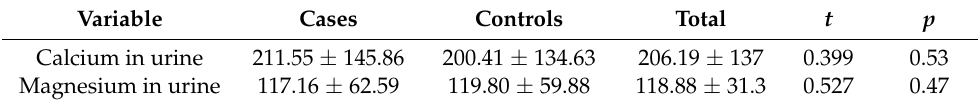
Table 3. Urinary calcium and magnesium levels in the case group and control group (mg/g creatinine).